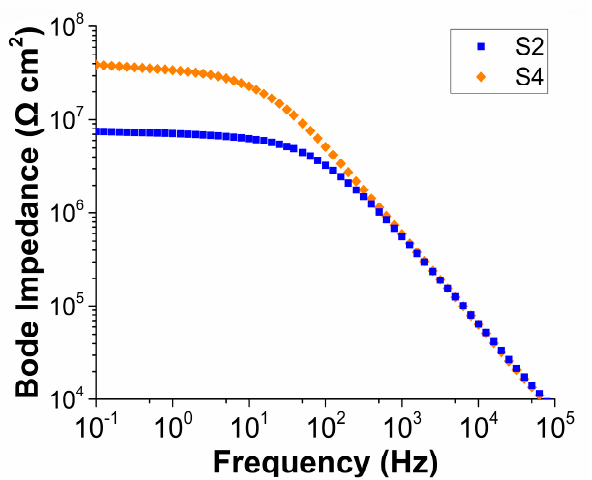
Figure 8. Bode plots of S2 & S4 after 20 h immersion in 0.1 wt.% NaCl.